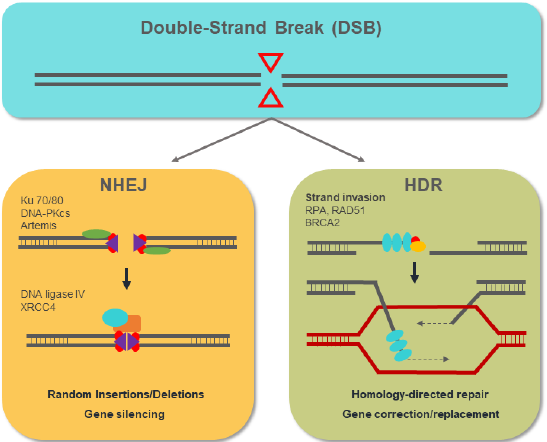
Figure 5. The non-homologous end-joining (NHEJ) mechanism involves the action of the proteins ku70/80, DNA-PKcs, and Artemis, with the ability to bind to the free DNA ends that are generated. The resected DNA ends are joined by the action of ligase IV with the insertion of a variable number of nucleotides (indels) that, in most cases, lead to the generation of null alleles. The homology-directed repair (HDR) pathway begins with the resection of the released DNA ends. The RPA, Rad51, and BRCA2 proteins act by binding and protecting the ssDNA that is generated. Through homologous recombination, the HDR pathway allows the introduction of DNA templates from exogenous donors at the double-strand break (DSB) site, replacing the target genomic